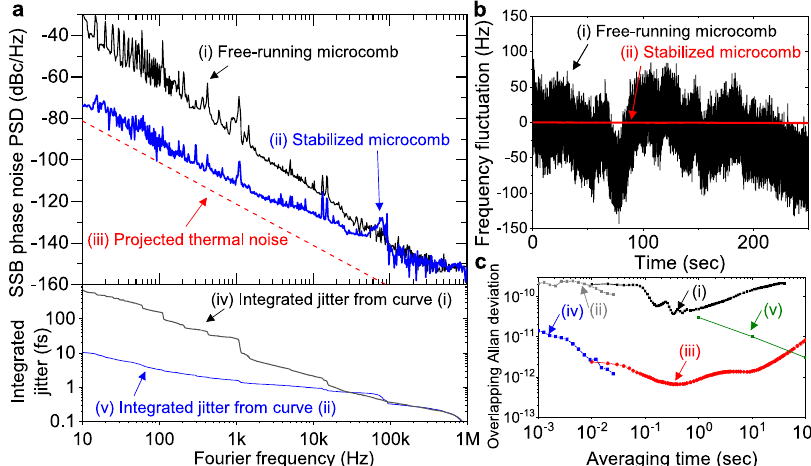
Fig. 3 Characterisation of the fi bre-stabilised silica microcomb. a 22-GHz microwave phase noise and integrated timing jitter. (i) Phase noise of the free- running microcomb. (ii) Phase noise of the 1-km fi bre-stabilised microcomb. (iii) Projected thermal noise-limited phase noise 53 of the 1-km fi bre-photonic stabiliser. (iv) Integrated root-mean-square timing jitter of the free-running microcomb. (v) Integrated root-mean-square timing jitter from the fi bre- stabilised microcomb. b Long-term frequency fl uctuation of the repetition rate. (i) Free-running microcomb (black). (ii) Fibre-stabilised microcomb (red). c Repetition-rate frequency instability of the microcomb. (i) Free-running microcomb (computed from curve (i) in Fig. 3b). (ii) Free-running microcomb (computed from curve (i) in Fig. 3a). (iii) Fibre-stabilised microcomb (computed from curve (ii) in Fig. 3b). (iv) Fibre-stabilised microcomb (computed from curve (ii) in Fig. 3a). (v) Chip-scale atomic reference (SA55, Microsemi). Source data for Fig. 3a, b and c are provided in the Supplementary